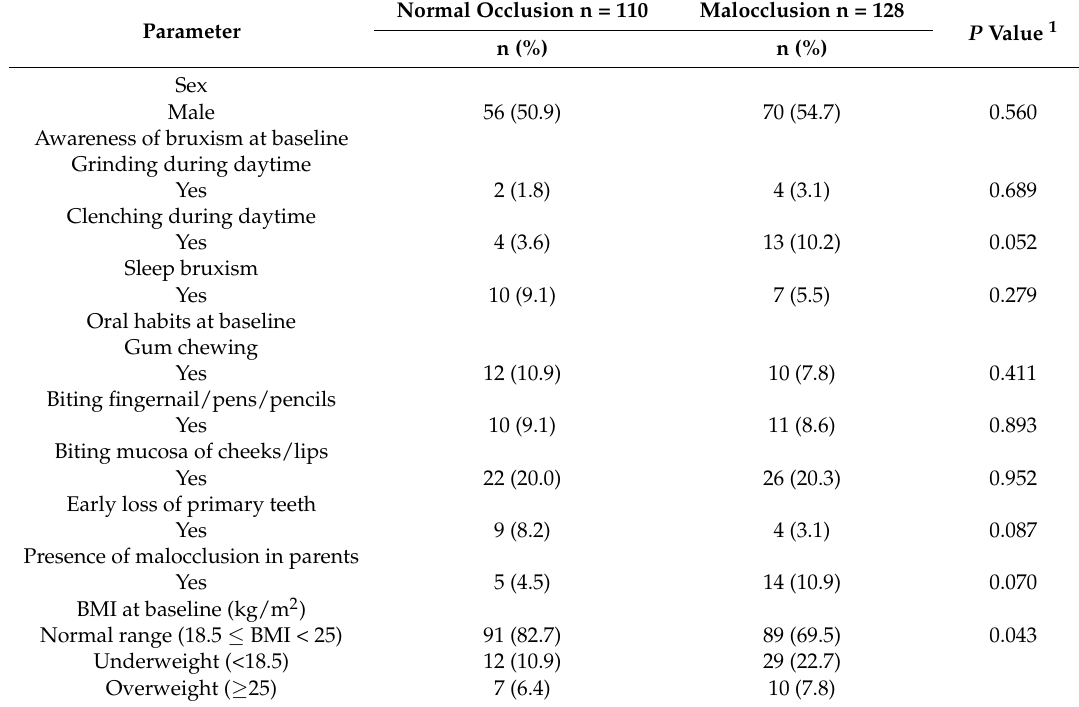
Table 3. Association between onset of malocclusion and other parameters among Okayama University students, Japan,